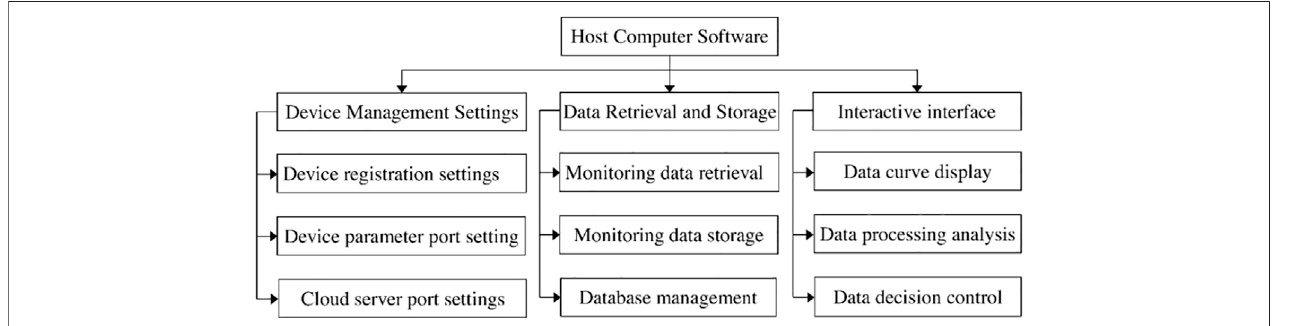
FIGURE 10 | Function module structure diagram of host computer.